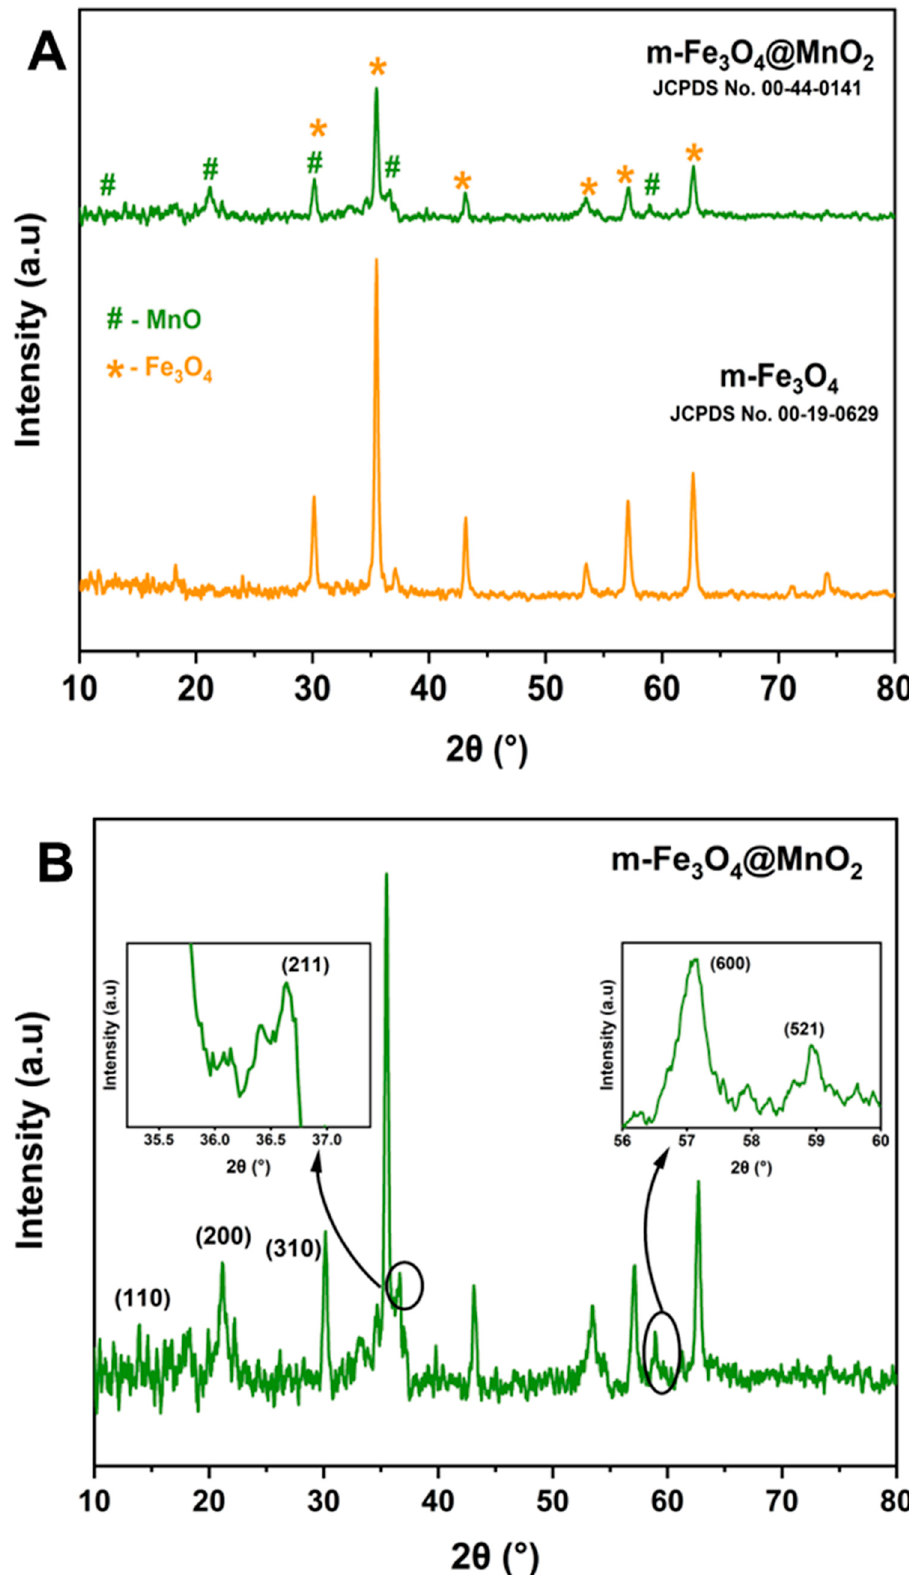
Figure 3. ( A ) Combined XRD patterns of m-Fe 3 O 4 and m-Fe 3 O 4 @MnO 2 nanocomposite and ( B ) crystal planes of MnO 2 in the nanocomposite (JCPDS-00-44-0141).